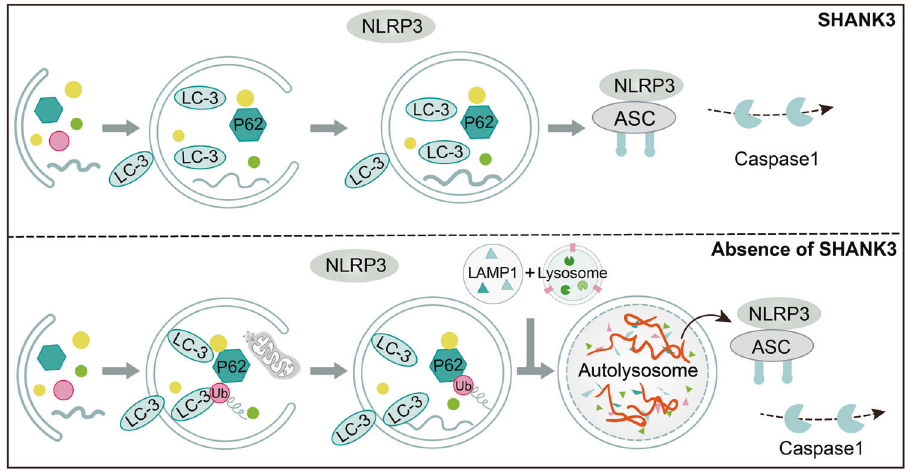
Fig. 7 Schematic diagram representing the effects of SHANK3 on the metabolism of NSCs and astrocytes. SHANK3 regulates the metabolism of NSCs and astrocytes through modulating the expressions of LC3B, LAMP1, NLRP3 and Caspase1.